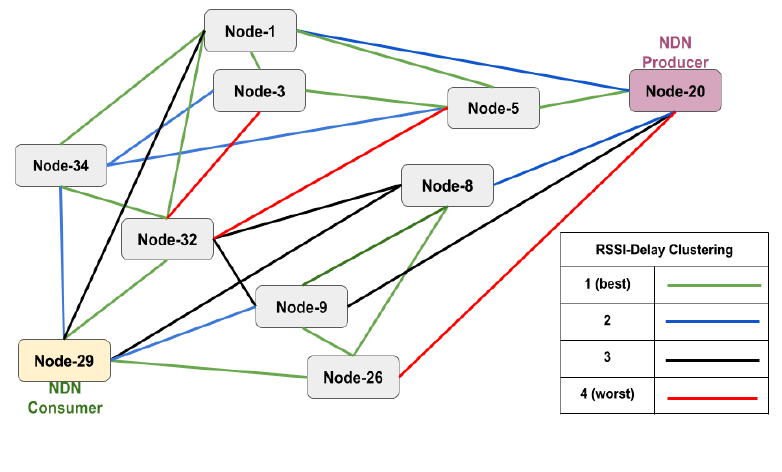
Figure 12. RSSI-Delay clustering results among network